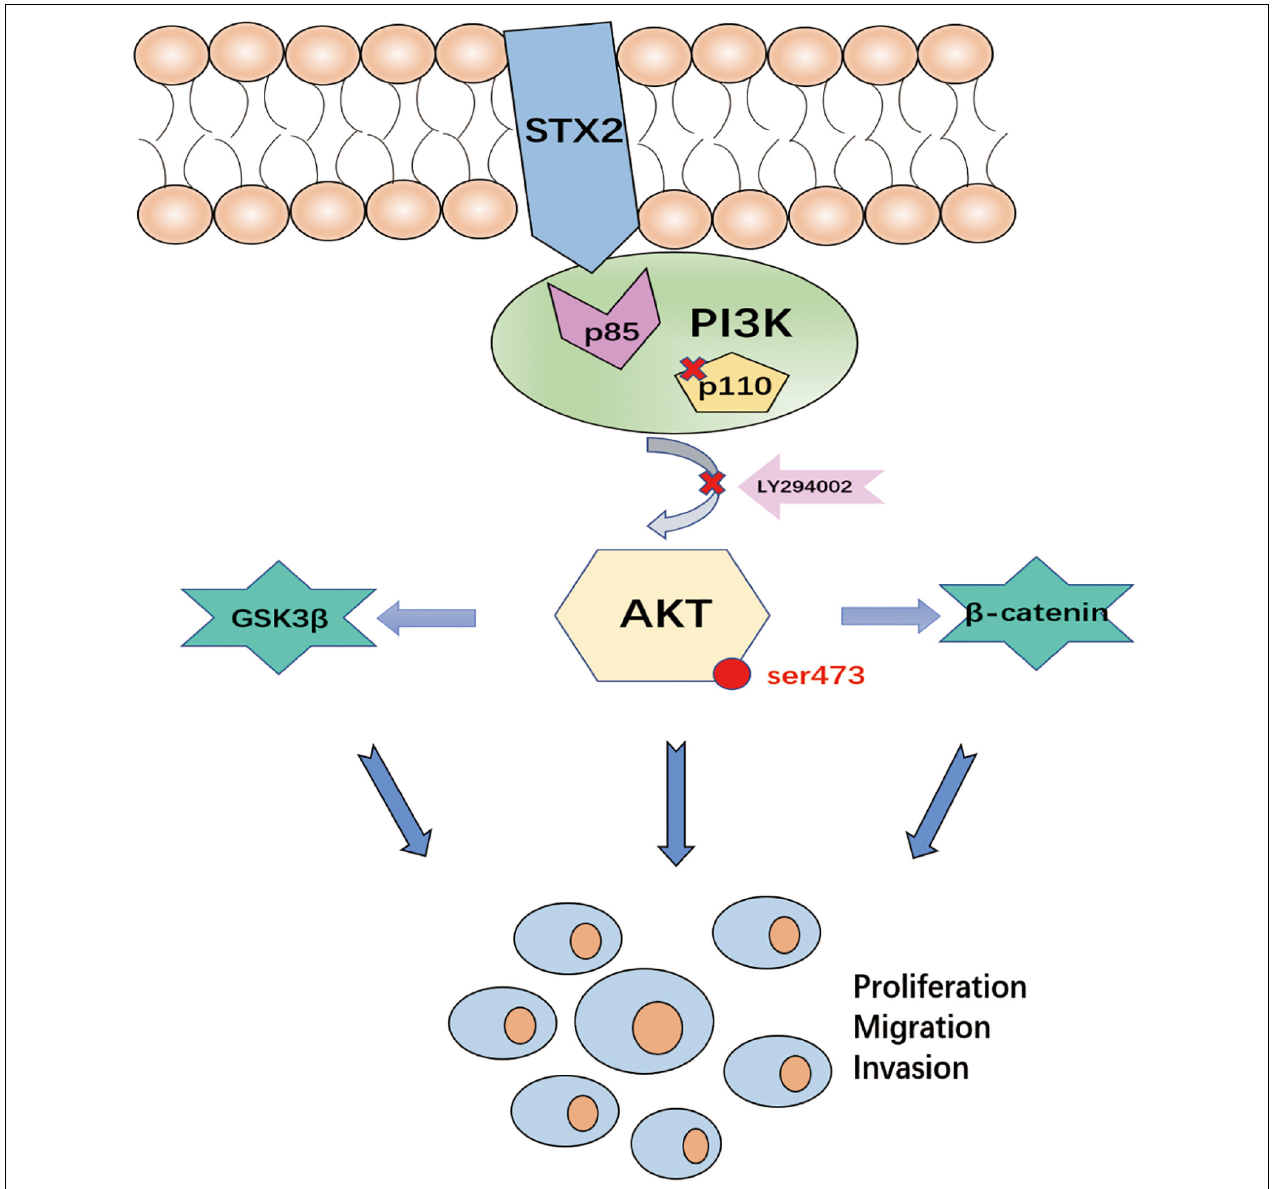
FIGURE 5 | The diagrammatic presentation of the underlying mechanism of STX2 promoting PE development. STX2 activated the PI3K-AKT pathway by interacting with PI3K p85 to prompt the trophoblast proliferation, migration and invasion. Therefore, down-regulation of STX2 in placenta contributed to the development of